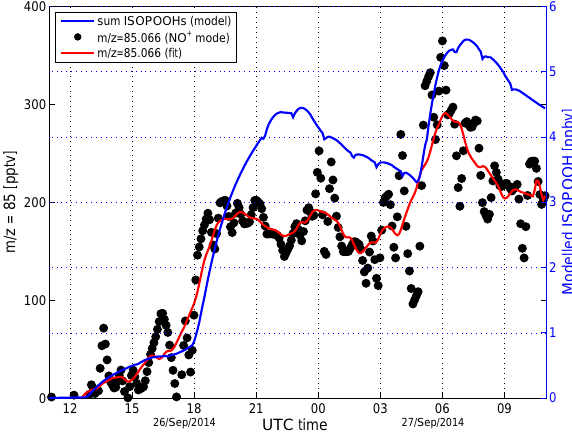
Figure 1. Comparison of main ISOPOOH fragment in NO + reagent ion mode (C 5 H 9 O + , m/z = 85.066) and MCM predictions at 1 × 10 5 moleculescm − 3 OH and up to 250ppbv isoprene. The sig- nal for the fragment follows the predicted trend but is about a fac- tor of 20 lower than the expected ISOPOOH concentration in the